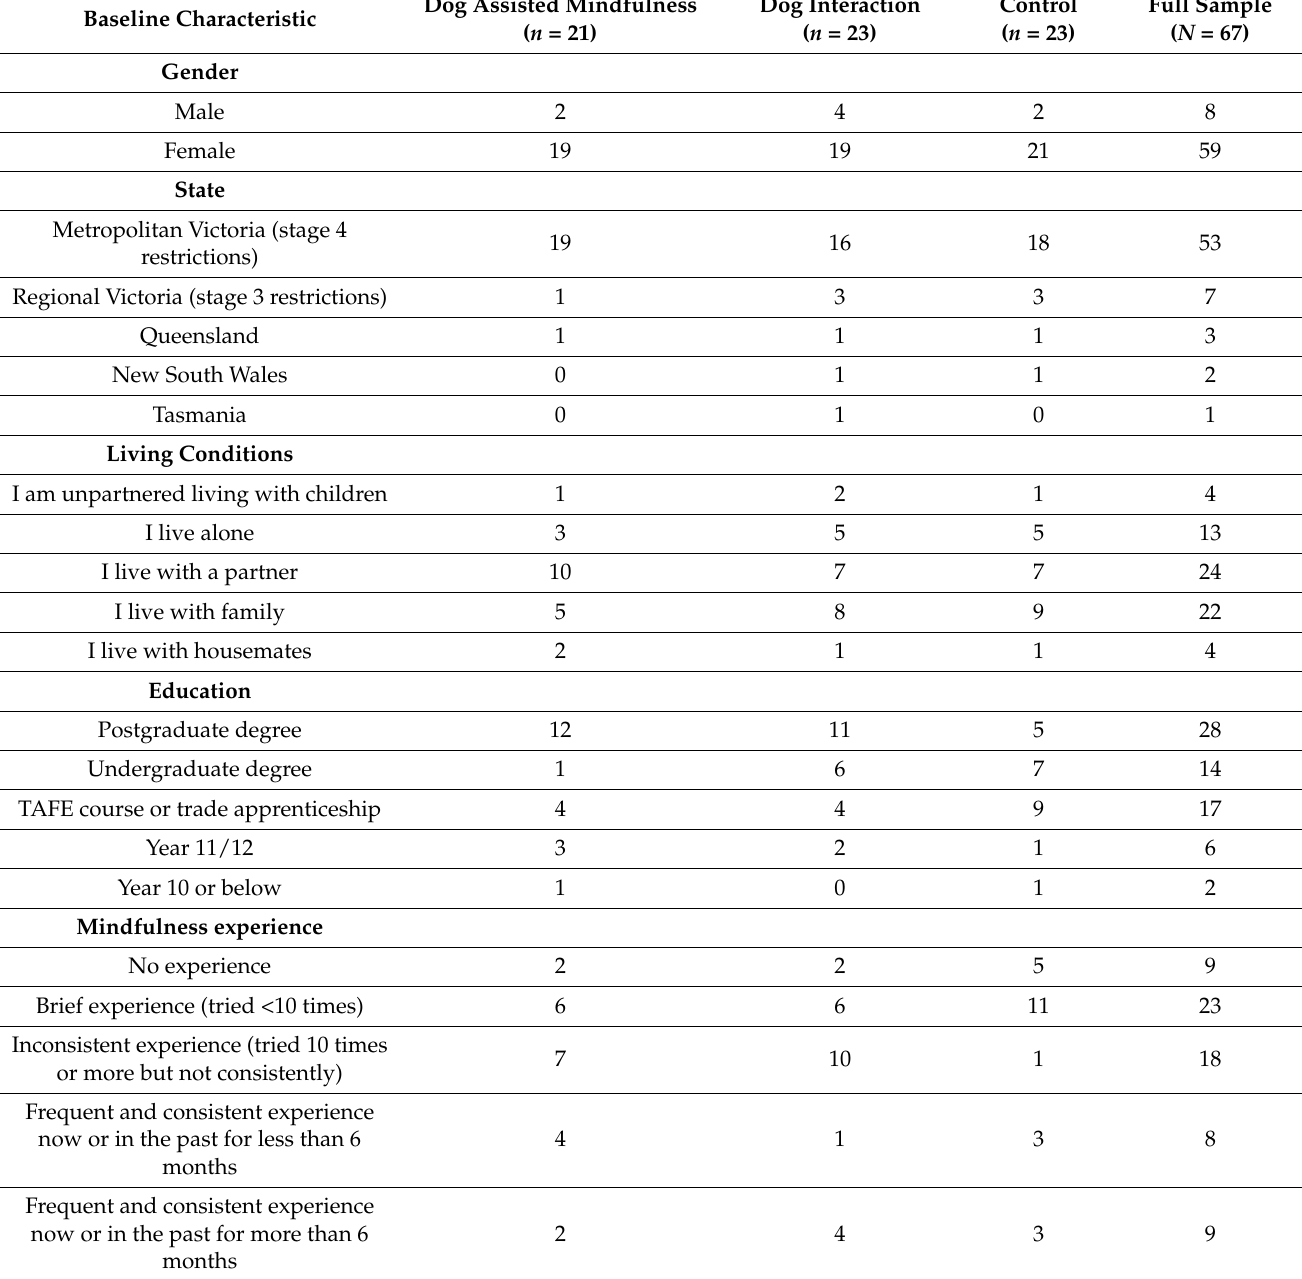
Table 1. Sociodemographic characteristics and participants’ mindfulness experience at